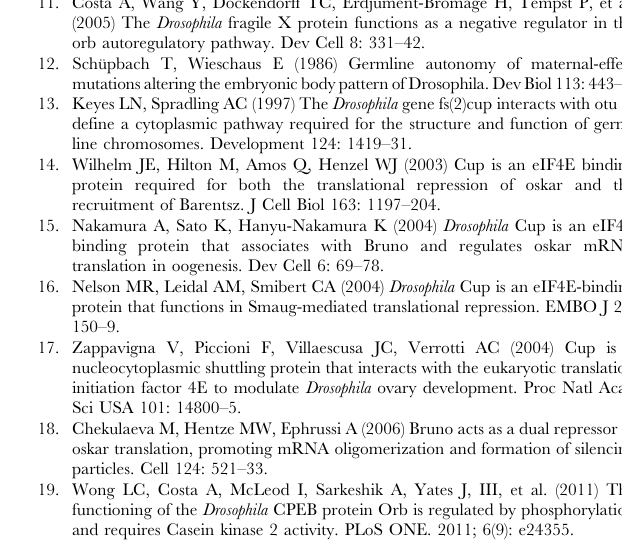
Figure S1 cup mutants have defects in oocyte determi- nation. Green: Encore. Red: Orb. WT: In wild type ovaries, Encore and Orb are concentrated in the presumptive oocyte in newly formed 16 cell cysts in the germarium. During early pre- vitellogenic stages the localization pattern is further refined so that only the oocyte has high levels of these two proteins. In the germarium of cup 8 ovaries, Encore and Orb are distributed in most of the cells in the 16-cell cyst (see arrow). The two proteins are also not properly concentrated into the presumptive oocyte in many older mutant egg chambers. Instead, several cells have high levels of Encore and Orb (see arrowheads).